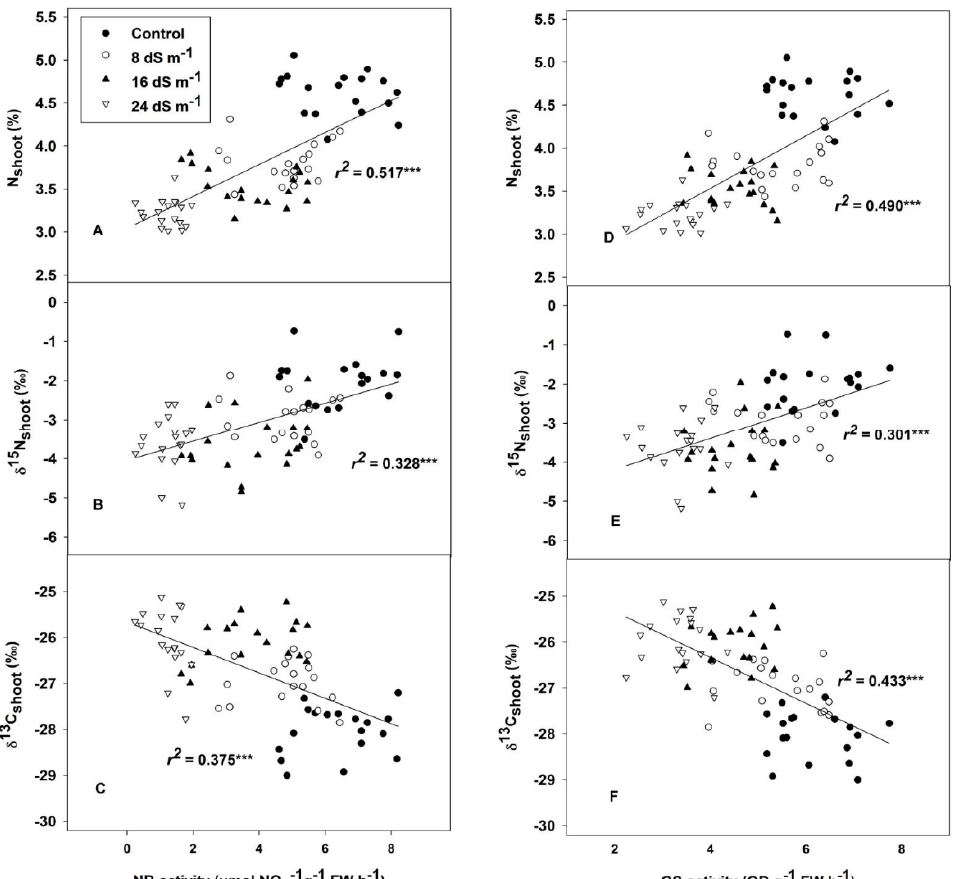
Figure 4. The relationship of nitrate reductase (NR) activity with nitrogen concentration (N%) ( A );nitrogenisotopecomposition( δ 15 N)( B );andcarbonisotopecomposition( δ 13 C)( C ).Therelationship of glutamine synthetase (GS) activity to nitrogen concentration (N%) ( D ); nitrogen isotope composition ( δ 15 N) ( E ); and carbon isotope composition ( δ 13 C) ( F ), in oat leaves across all treatments and genotypes. *** p <